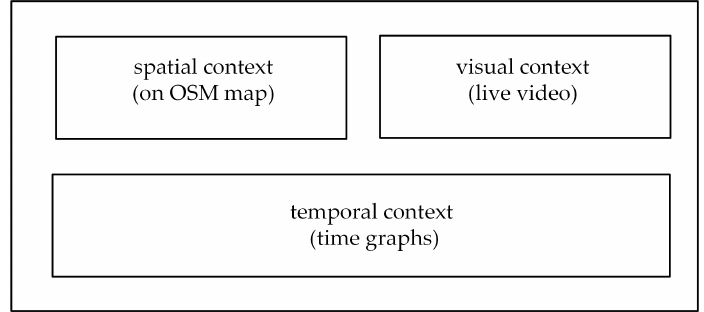
Figure 2. Layout of the